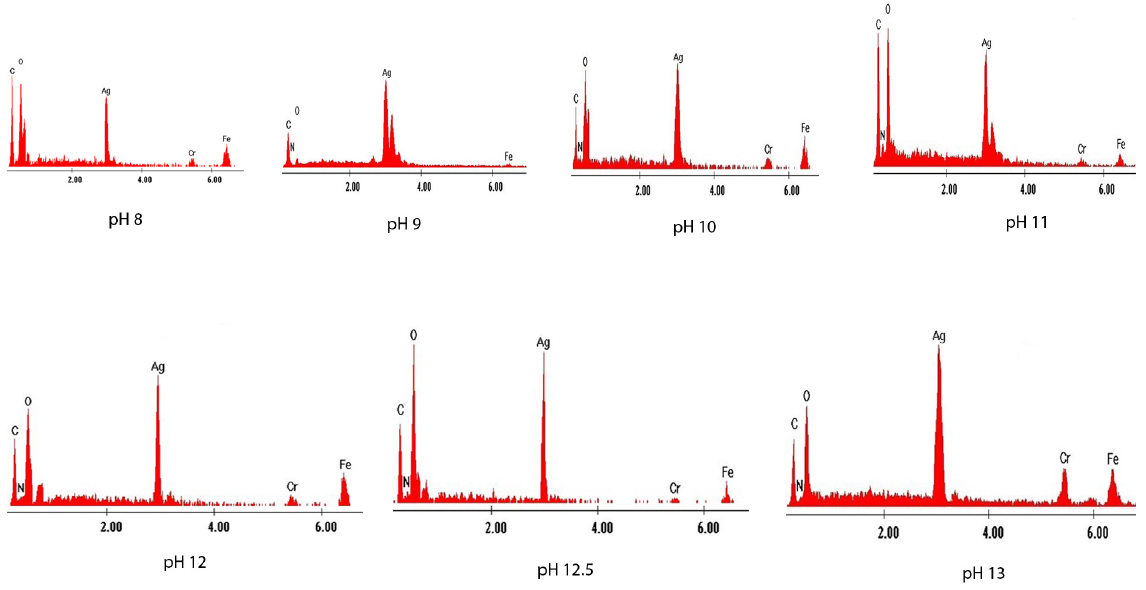
Figure 4. Energy-dispersive X-ray spectra recorded for samples prepared at pH values between 8 and 13.